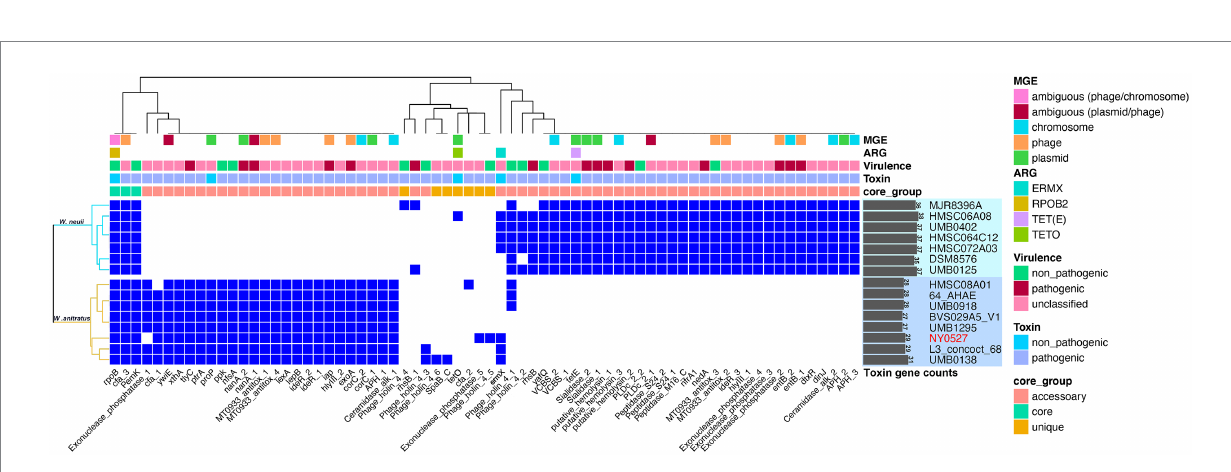
FIGURE 4 Pathogenic factor genes predicted in W. neuii and W. anitratus genomes. Hierarchical clustering was performed using the presence/absence pattern of the genes in the genomes. A blue cell in the heatmap indicates the presence of a gene. The virulence and toxin genes were defined as pathogenic when they were identified as pathogenic by both the HMM model and the random forest